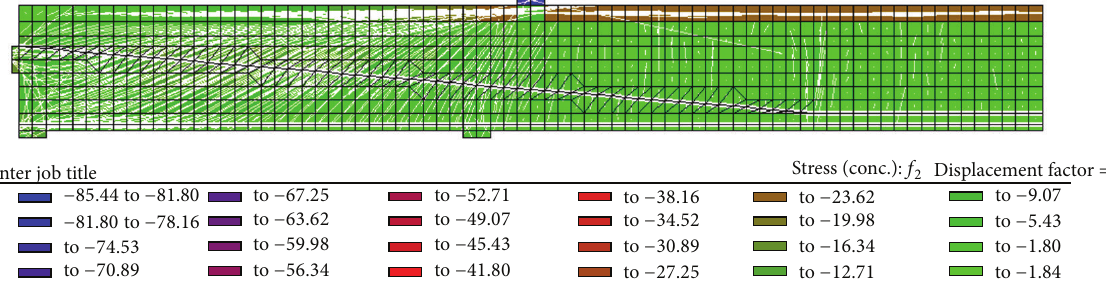
Figure 11: Finite element model of half